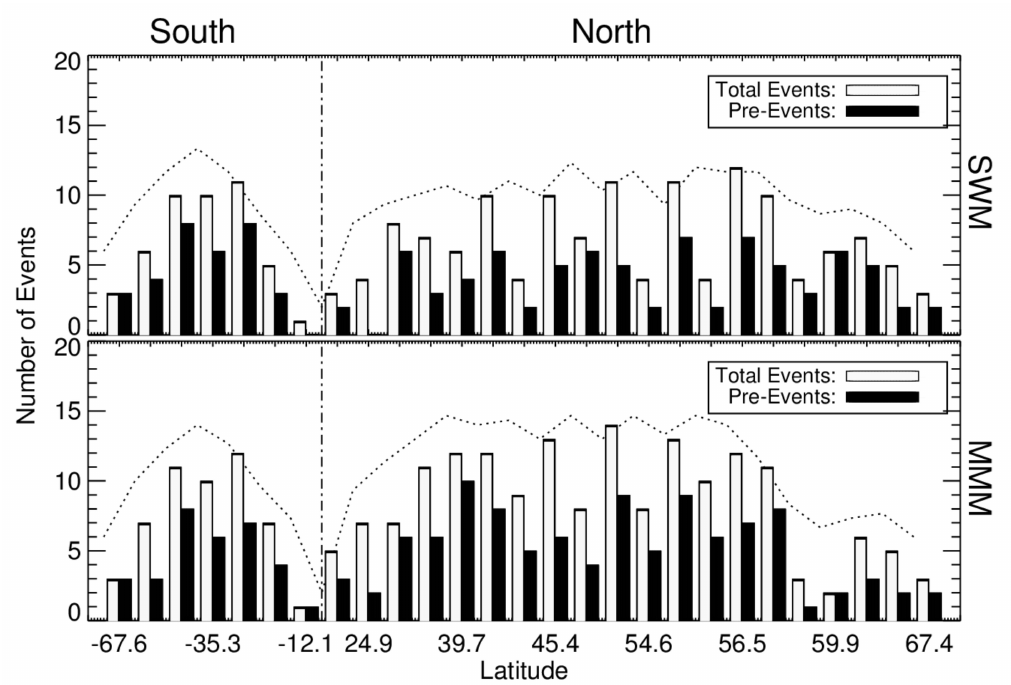
Figure 4. Latitudinal distribution of weak ionospheric response events for 27 ionosondes. White bars represent the total number of weak response events; black bars show the number of events with pre-storm disturbed geomagnetic